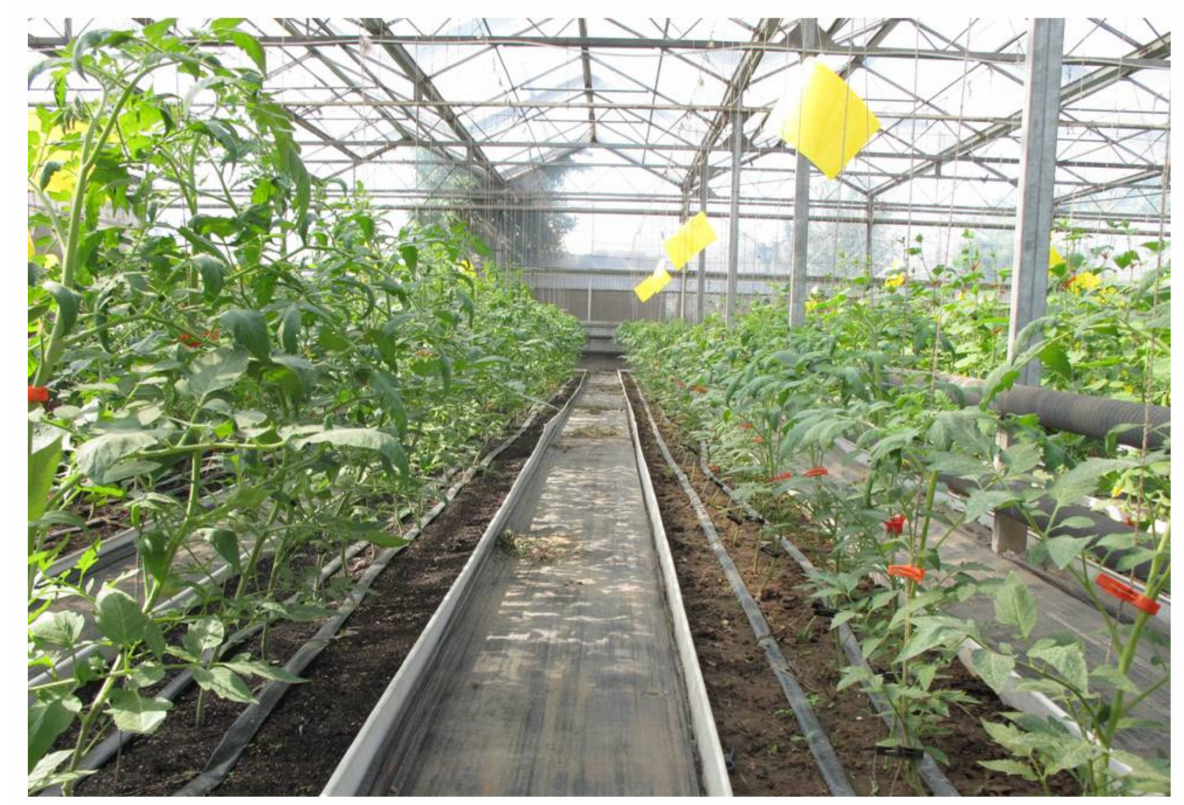
Figure 1. Visual growth difference in representative tomato plants under substrate-based ( left ) and soil cultivation ( right ).